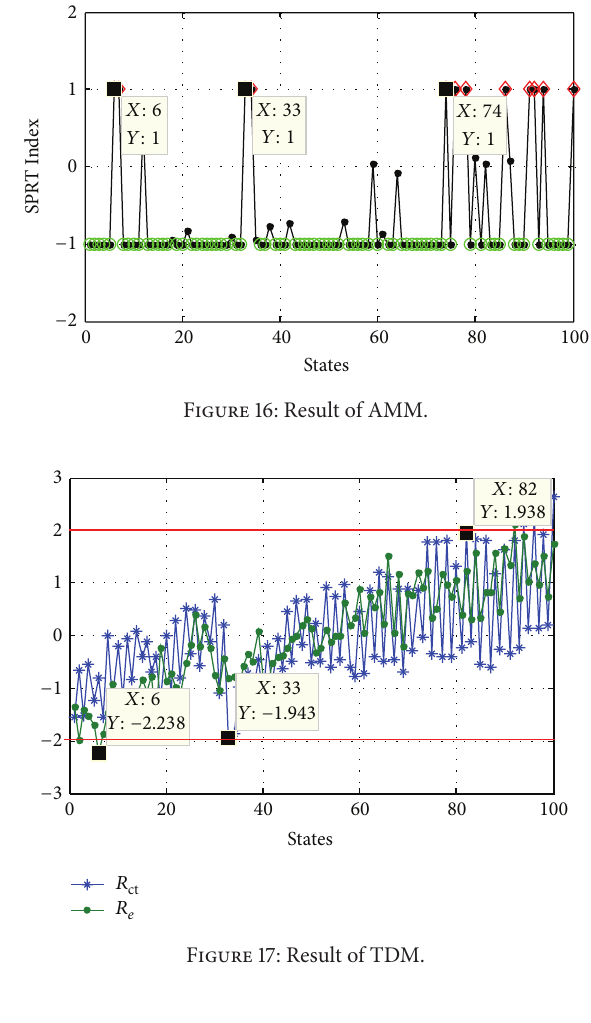
after dimensionality reduction. ct